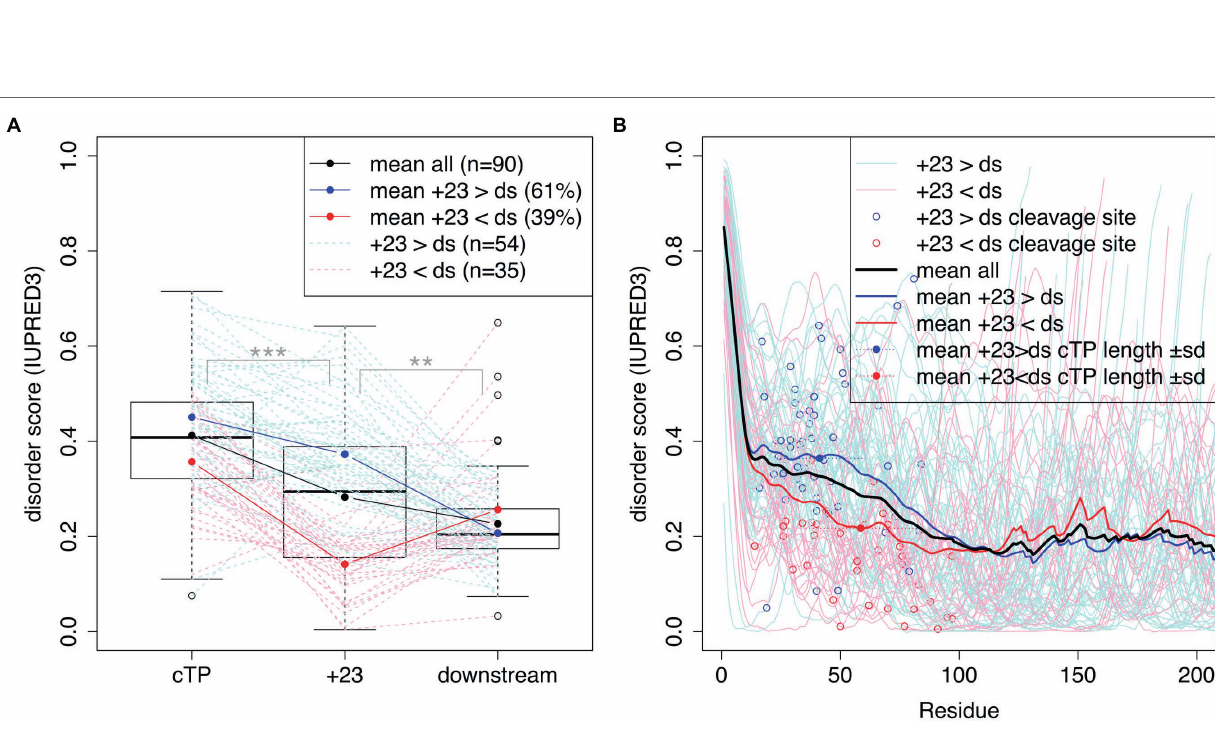
FIGURE 3 | RBCS2-cTP shows a similar reliance on sequence extension, in contrast to mTPs. (A–E) Rubisco small subunit 2 (RBCS2) cTP and extensions were used to drive Venus localization as in Figure 1 ; green arrows highlight pyrenoid location. (F,G) mTPs of mitochondrial carbonic anhydrase 4 (CAH4) and γ -carbonic anhydrase 2 (CAG2) were assessed by epifluorescence as before, and also by confocal fluorescence microscopy in the presence of a MitoTracker dye (false-colored in cyan) to provide a visual co-localization guide to assess mitochondrial localization of Venus.